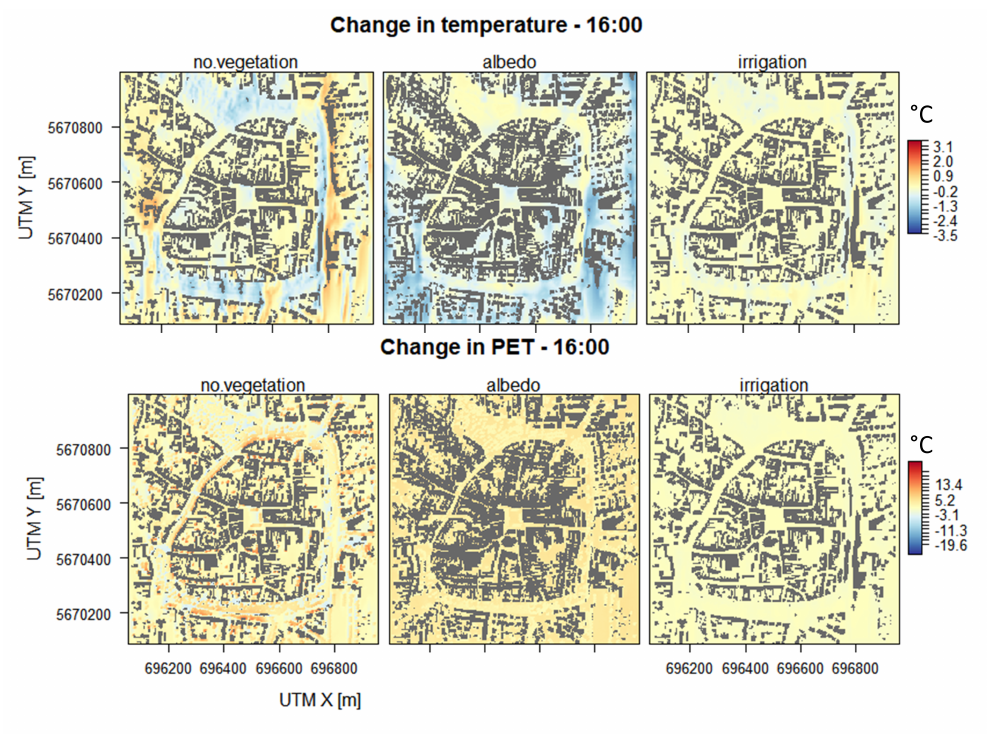
Figure 7. Differences in T a (upper panel) and PET (lower panel) between the scenarios 1, 2, and 3 and the current state at a height of 1.4 m above the ground on 04.07.2015 at 16:00. (Grey areas: